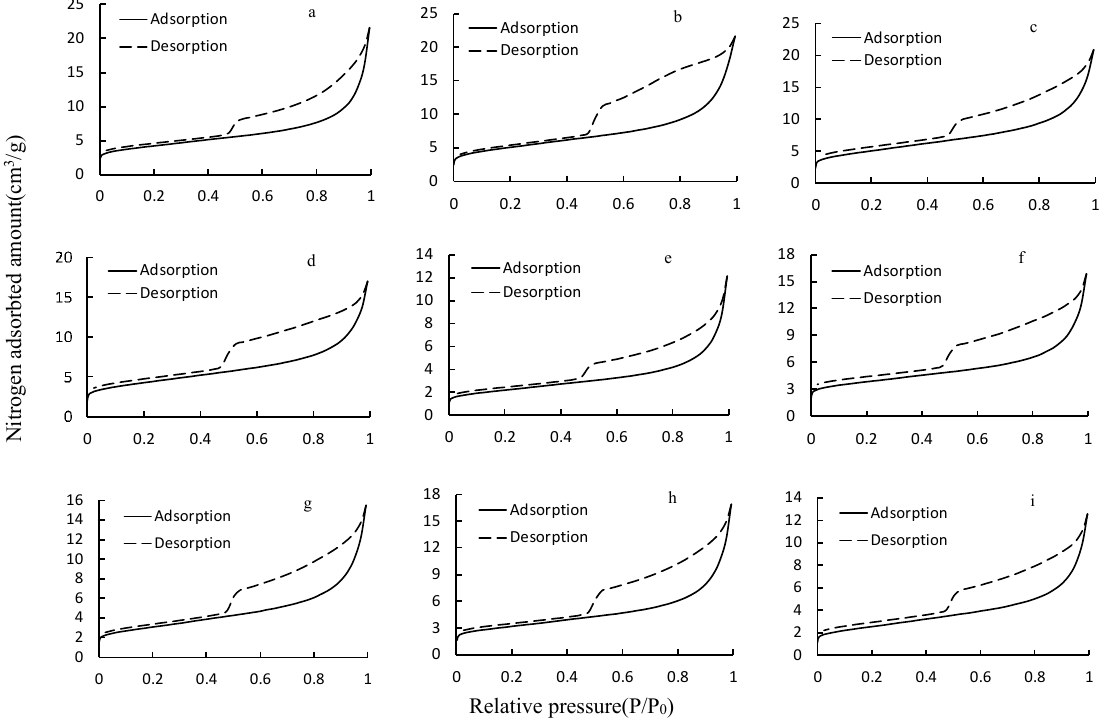
Figure 2. Low-temperature nitrogen adsorption and desorption isotherms. ( a ) S1 well, 746.8 m; ( b ) S1 well, 789.2 m; ( c ) S1 well, 823.7 m; ( d ) S2 well, 611.7 m; ( e ) S2 well, 632.03 m; ( f ) S2 well, 653.6 m; ( g ) S2 well, 662.0 m; ( h ) S2 well, 669.6 m; and ( i ) S2 well, 736.53